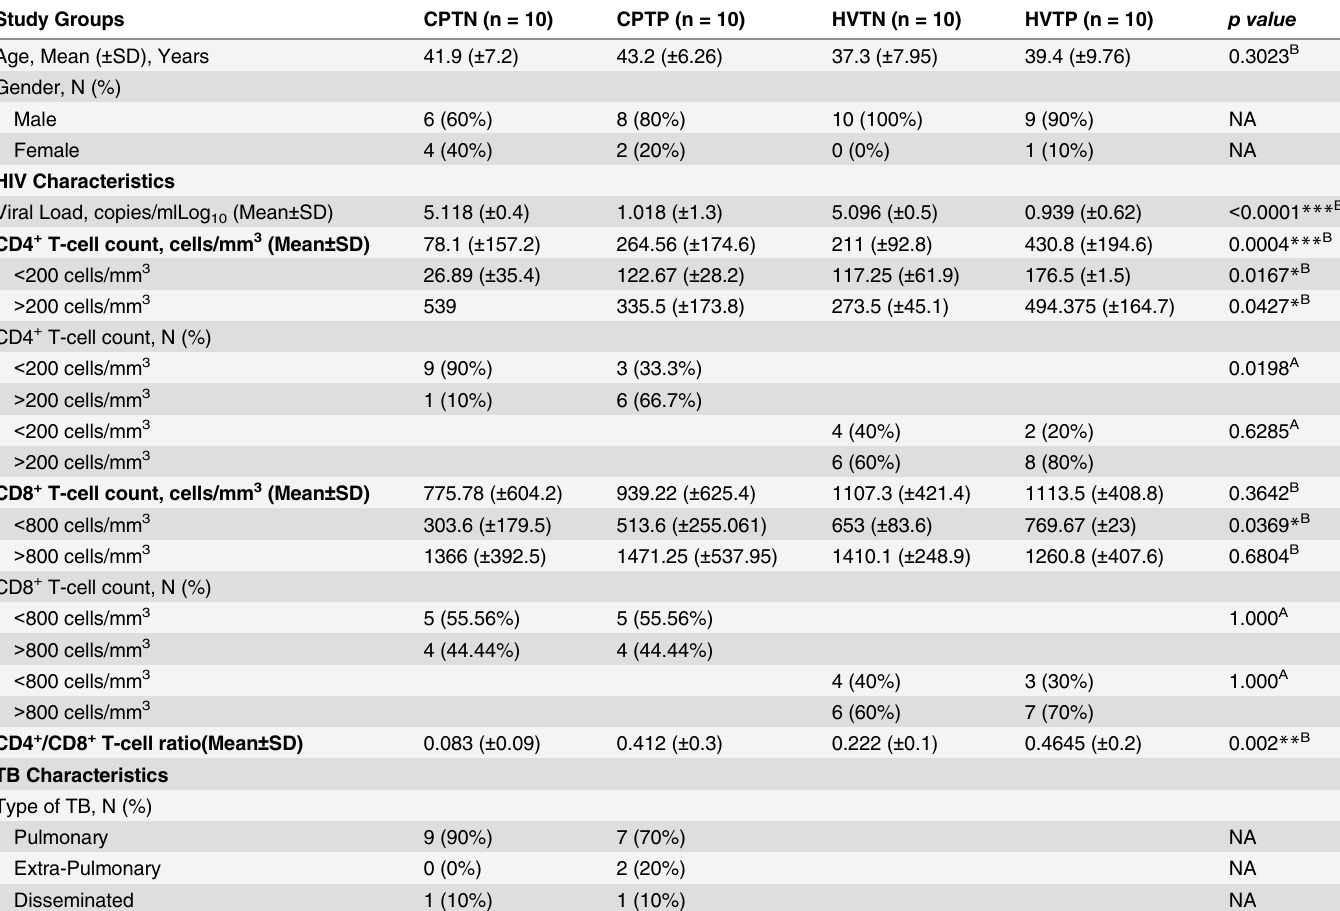
Table 1. Demographic, clinical and laboratory characteristics of study